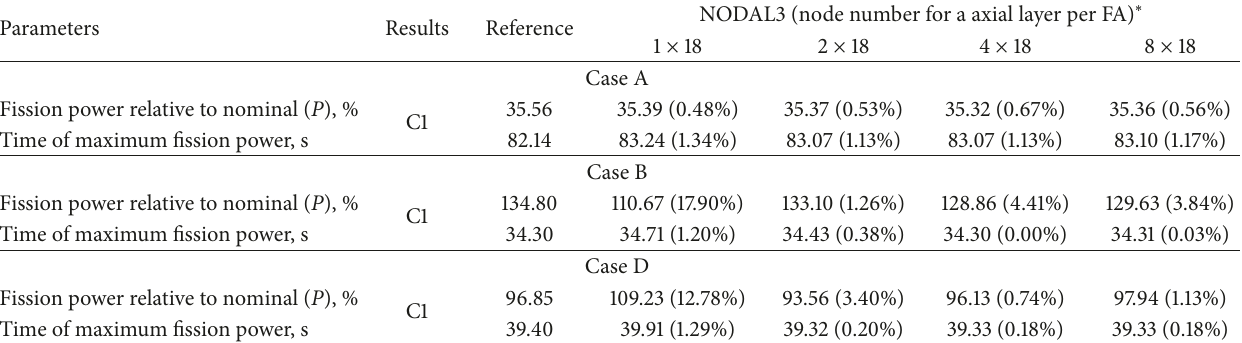
Table 6: Effect of axial node number per FA for fission power and time of peak fission power in Cases A, B, and D.